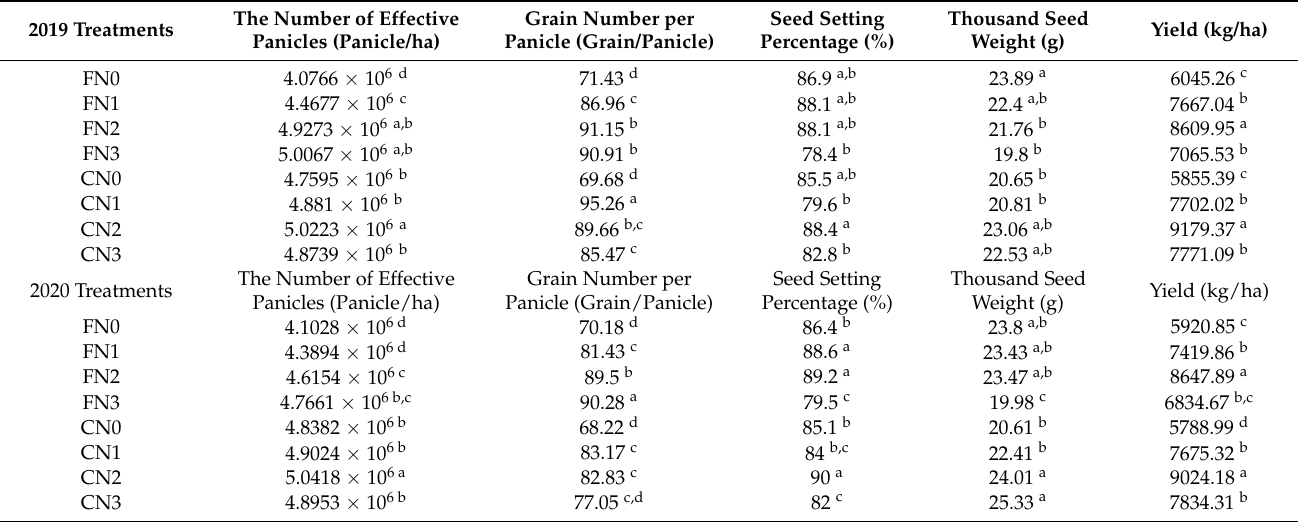
Table 2. Effects of the different water and nitrogen treatments on the rice yield and its